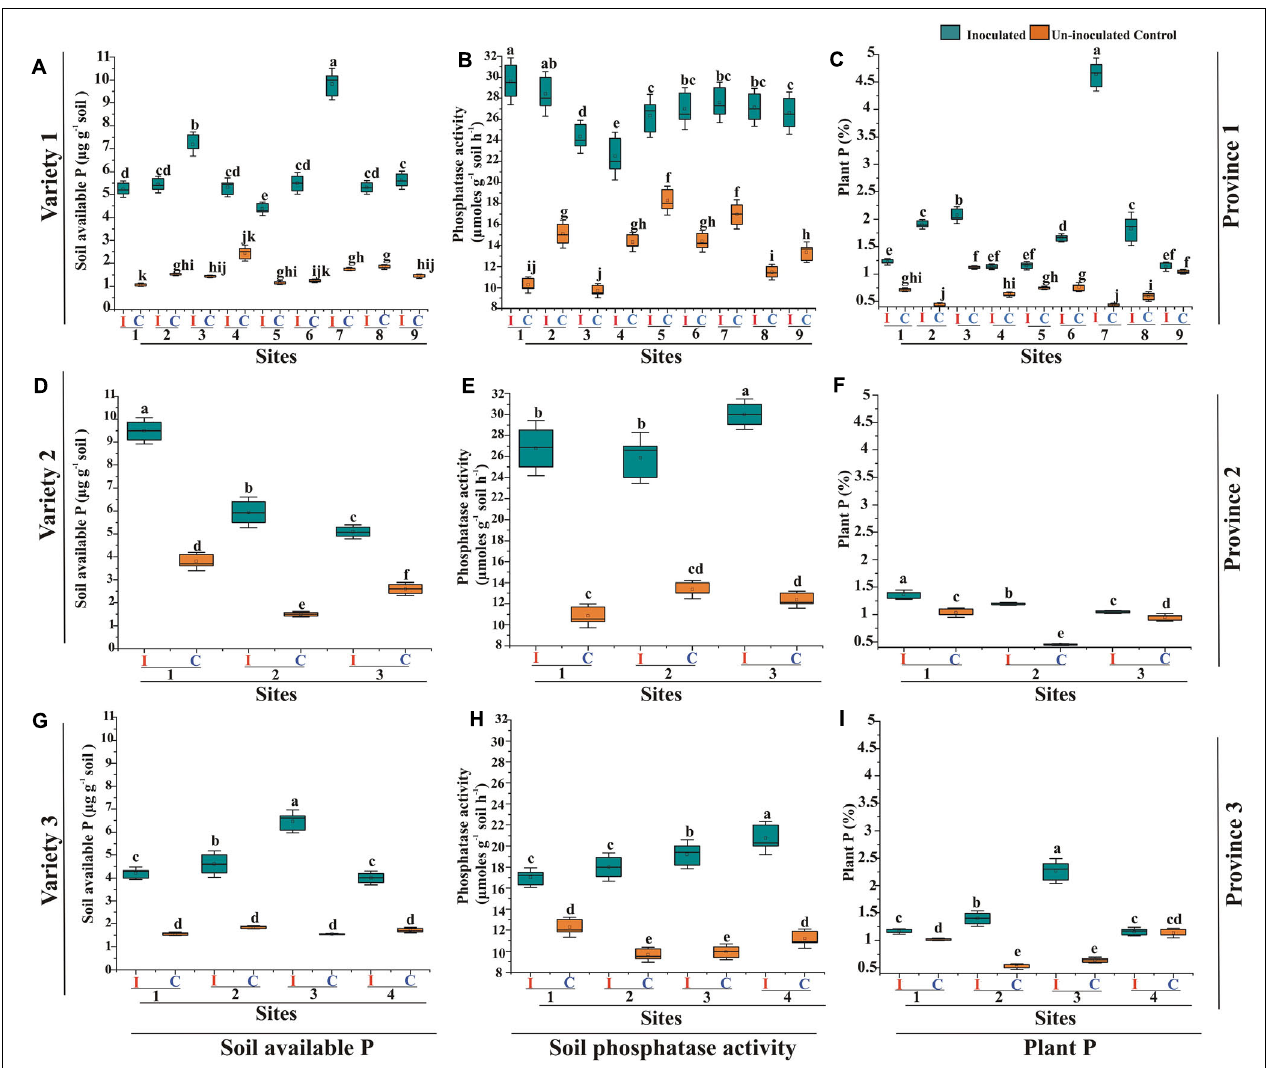
FIGURE 8 | Effect of PSB inoculation on soil and plant P parameters of wheat varieties grown in soils from different agro-ecological zones compared to uninoculated controls. Evaluation of consortium-1 for soil available P (A) , soil phosphatase activity (B) , and plant P content (C) of wheat variety-1 grown in soils of province-1. Evaluation of PSB consortium-2 for soil available P (D) , soil phosphatase activity (E) , and plant P content (F) of wheat variety-2 grown in soils of province-2. Evaluation of consortium-3 for soil available P (G) , soil phosphatase activity (H) , and plant P content (I) of wheat variety-3 in soils of province-3. Different small (a, b, c) letters above each box indicate significantly differences between the treatments according at p < 0.05. I: Inoculated, C: Uninoculated control. For Province 1 : Site 1: Dera Ghazi Khan, Site 2: Faisalabad, Site 3: Jhang, Site 4: Rahim Yar Khan, Site 5: Multan, Site 6: Sheikhupura, Site 7: Gujranwala, Site 8: Sialkot, Site